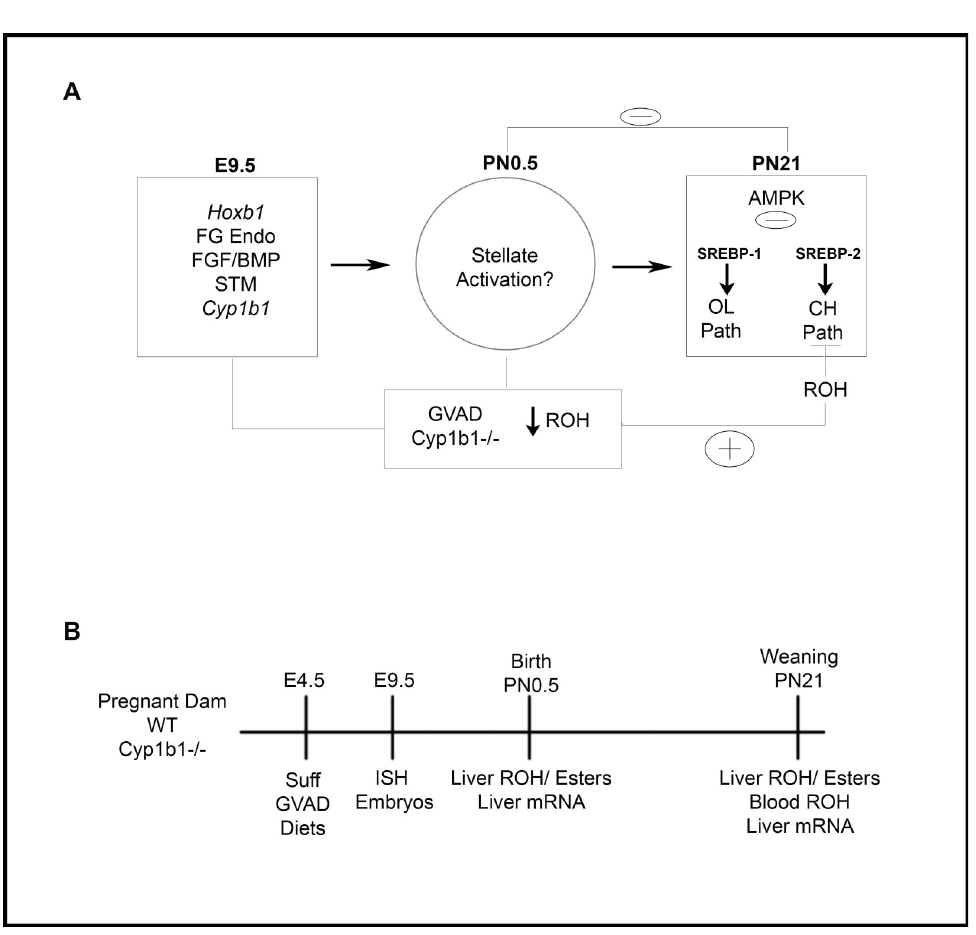
Fig 1. Model and design for studies of effects of Suff and GVAD diets on timed mating of WT and Cyp1b1-/- mice. Design to compare effects of GVAD and Cyp1b1 deletion at different stages of development ( Left ) Mid-gestation; E9.5 liver budding Foregut/FG, Endoderm (Endo), Septum Transversum Mesenchyme (STM). (Center ) PN0.5; Stellate activation markers examined. ( Right ) PN21; suppression of oleate and cholesterol pathway genes (A). Design for assessment of effects of a retinol-depleted maternal diet (GVAD versus Suff) and of Cyp1b1 deletion (WT versus Cyp1b1-/- pups) on livers at birth (PN0.5) and weaning (PN21). Gene expression and retinoid content in pooled livers are compared on the day after birth (n = 3 pools) and on individual pups at PN21 (B).